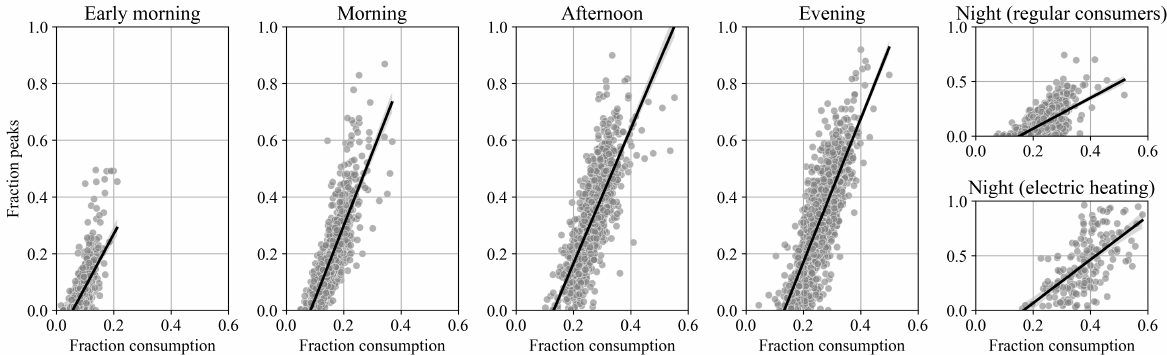
Figure 14. Relation between the fraction of consumption and peak demands in the time periods at the daily level, with an OLS regression estimate